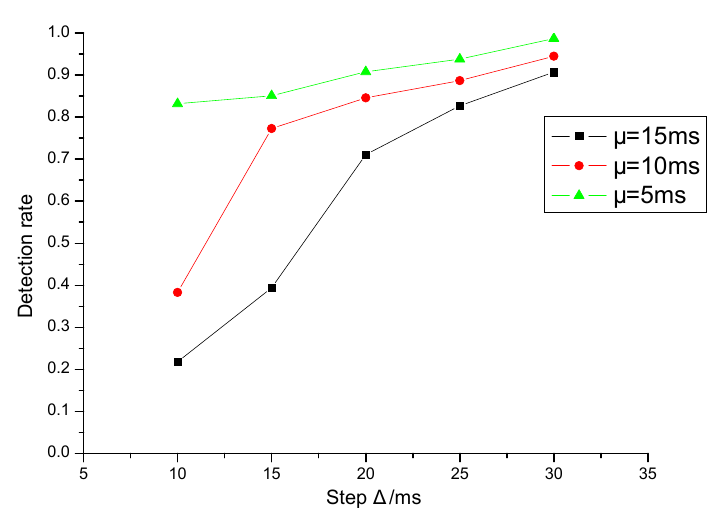
Figure 8. Effect of network jitter on detection rate.